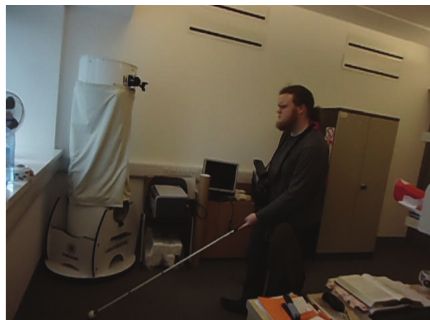
Figure 11: Calibrating Kinect-aided navigation system by letting a visually impaired person walk using it along with white cane.